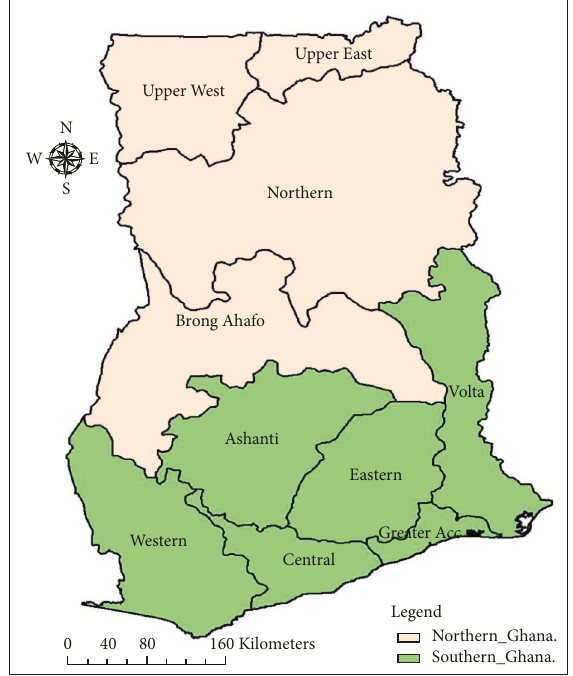
Figure 1: Southern